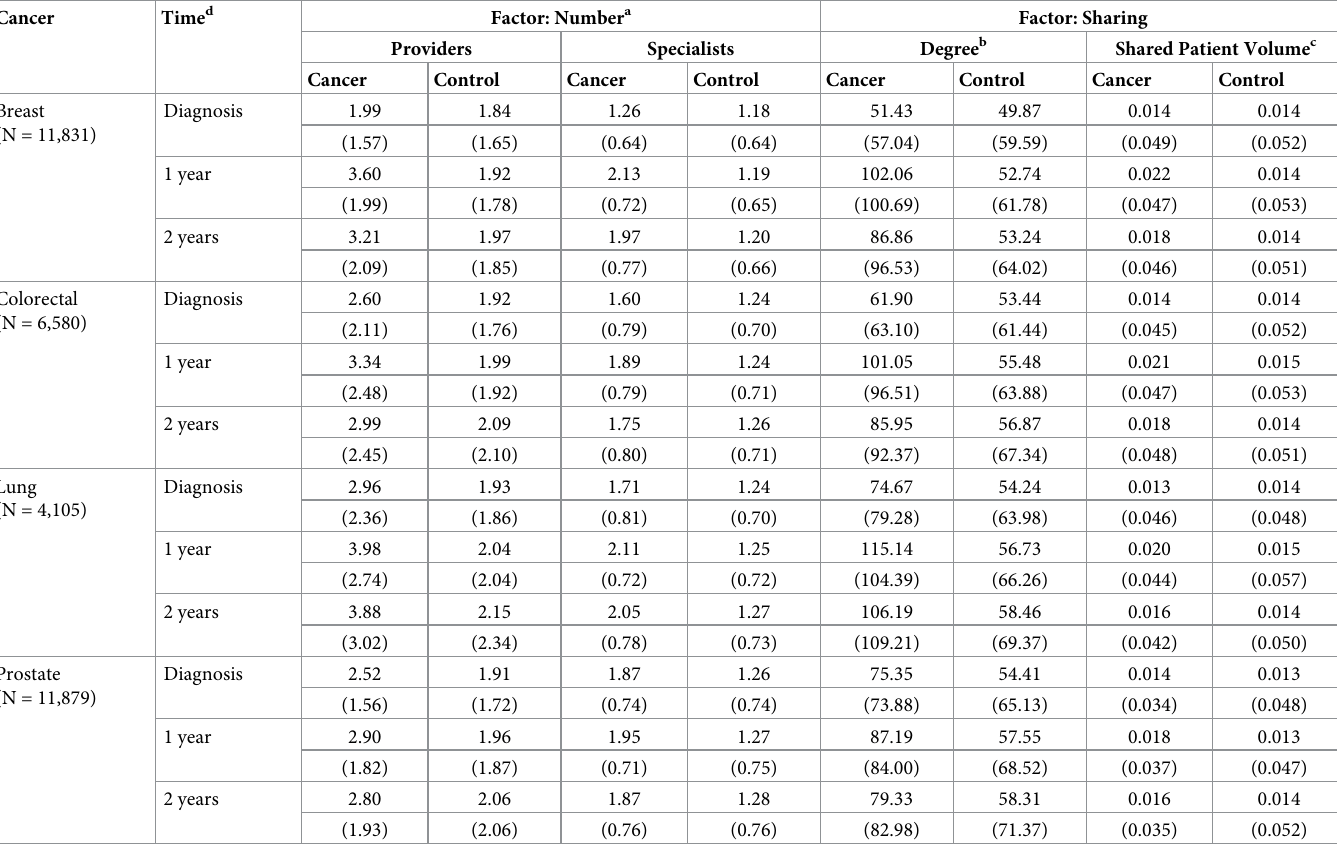
Table 1. Provider team characteristics by cancer and time period: Mean (standard